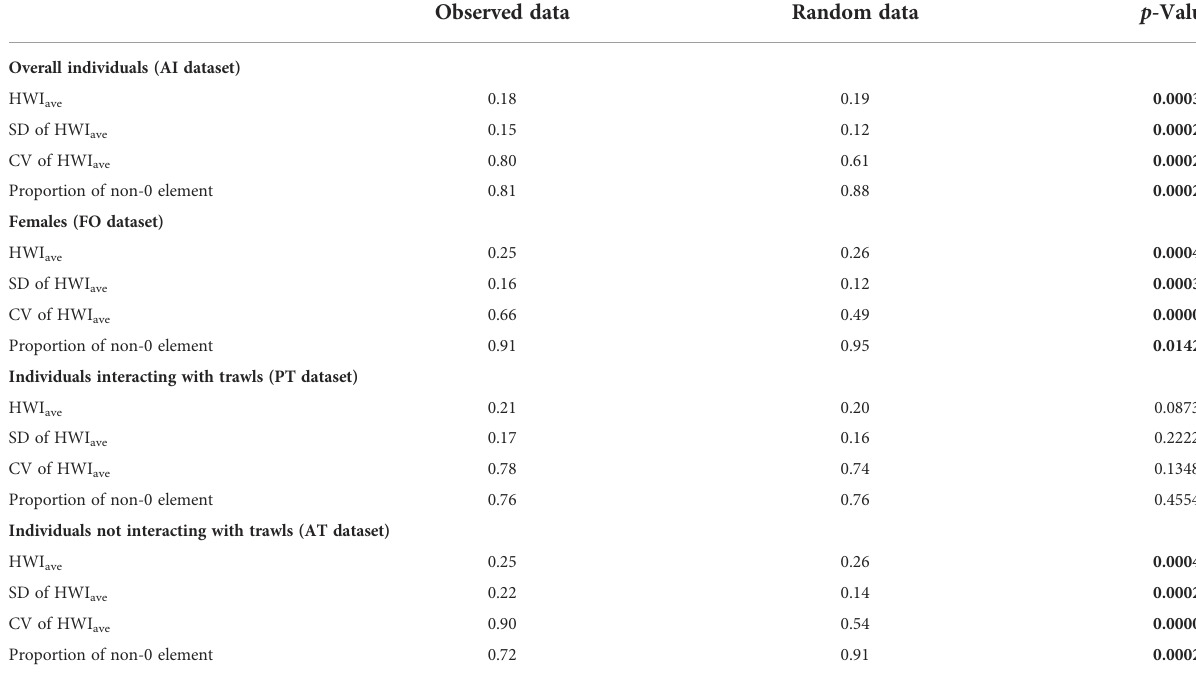
TABLE 1 Permutation tests for preferred and avoided associations of bottlenose